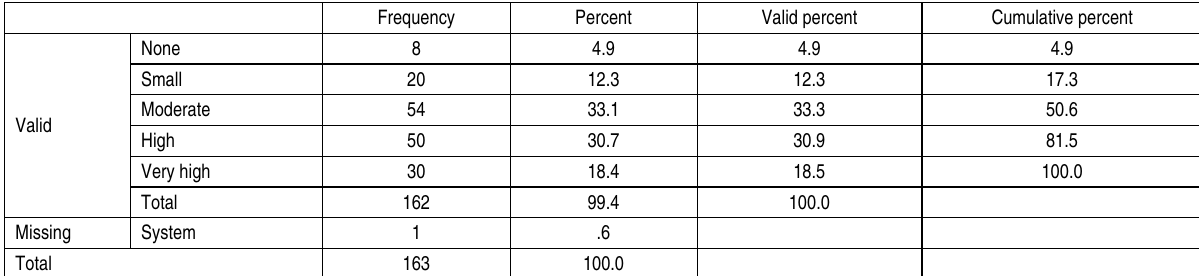
Table 1. Willingness of supervisors to stand up for subordinates: supervisor’s response